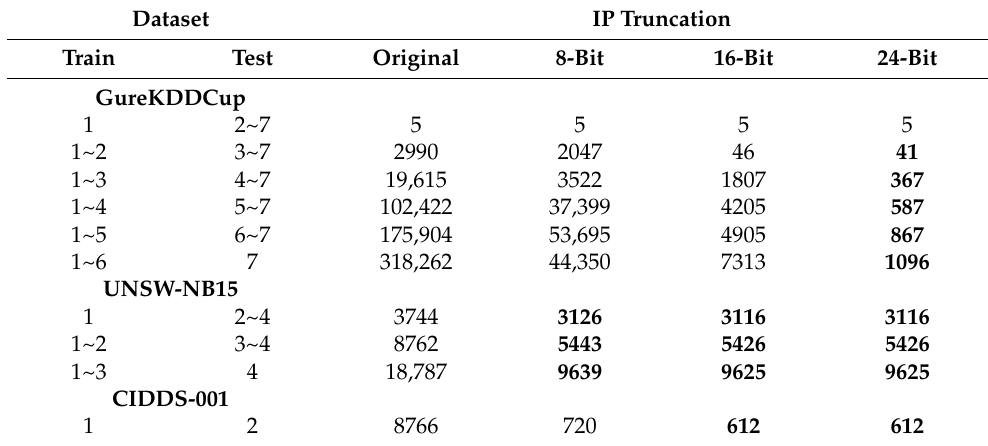
Table 4. Number of Nodes for each C4.5 Tree Model in Full GureKDDCup’99, UNSW-NB15, and CIDDS-001.